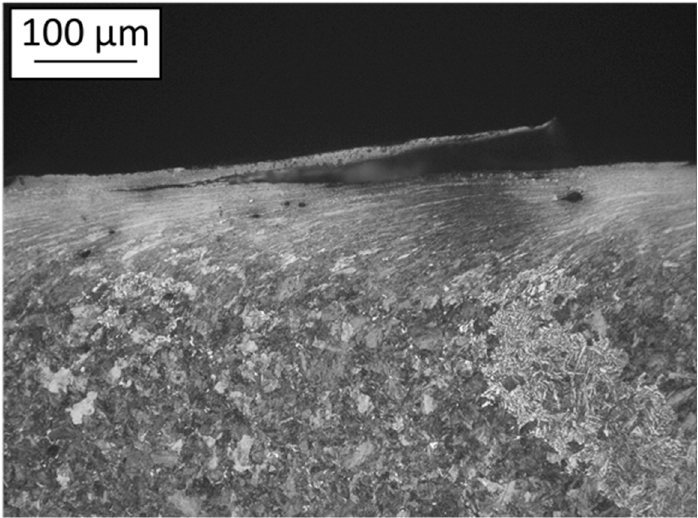
Figure 6. Cross-section of the wheel disc T03 at the end of the continuous test (200,000 cycles). The accumulation of plastic deformation during the tests was also proved by the hardness profiles obtained on the disc cross-sections (Figure 7).